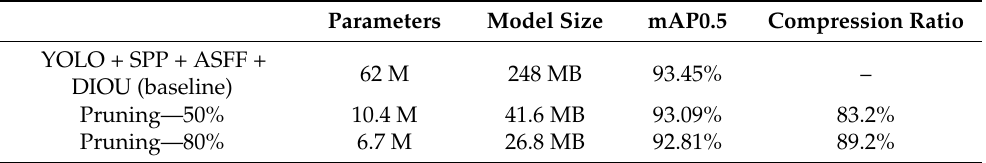
Table 2. Results for the MCP method.